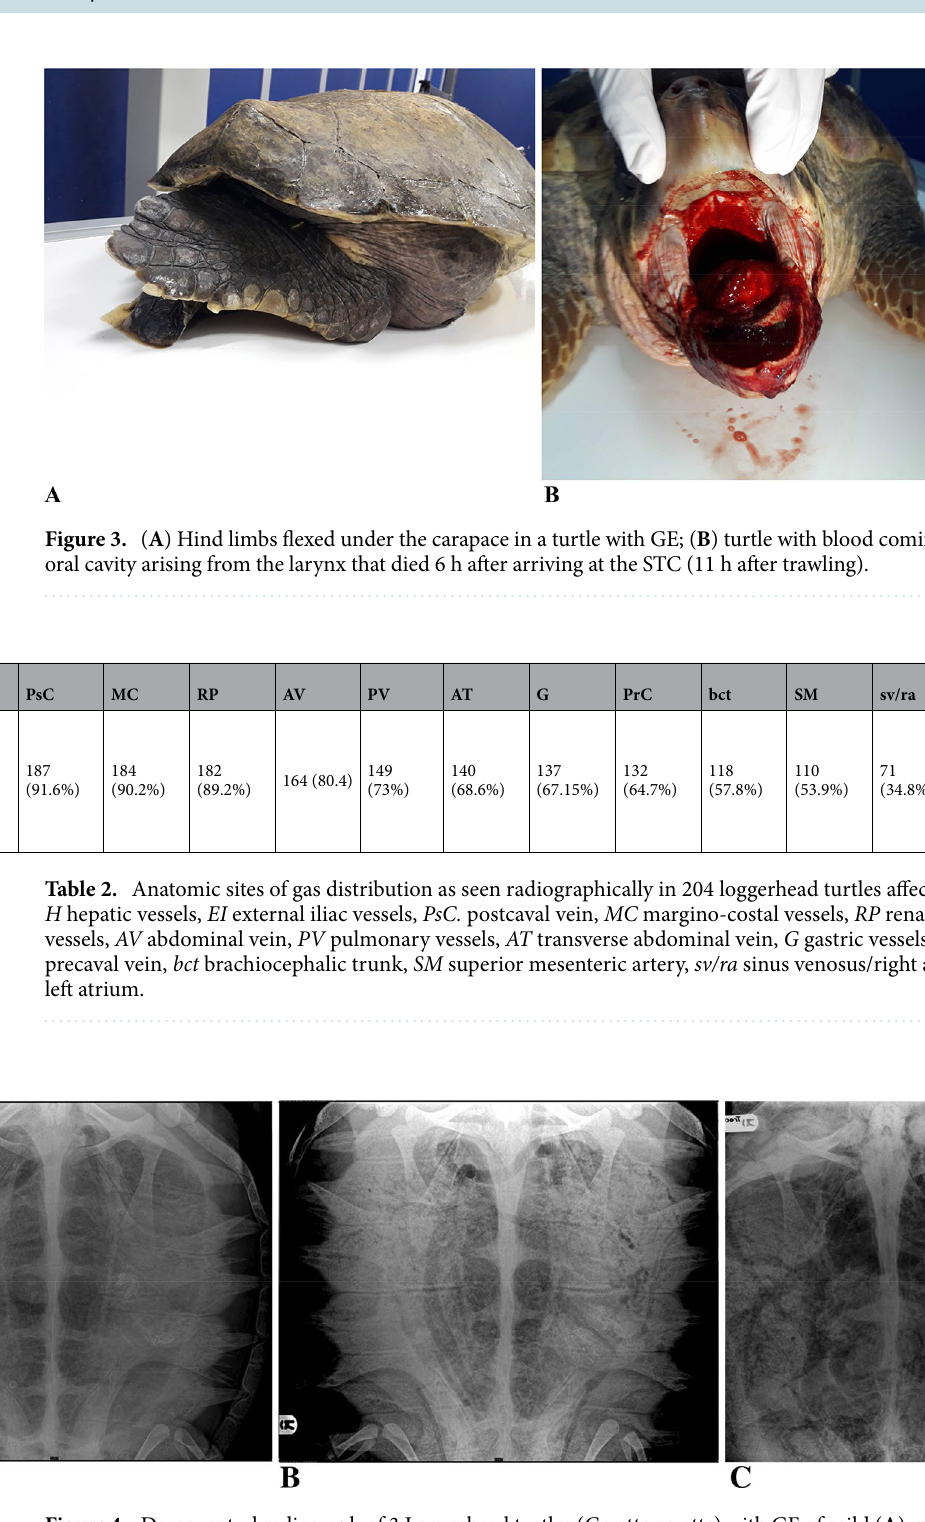
Figure 4. Dorsoventral radiograph of 3 Loggerhead turtles ( Caretta caretta ) with GE of mild ( A ), medium ( B ) and severe ( C ) radiographic